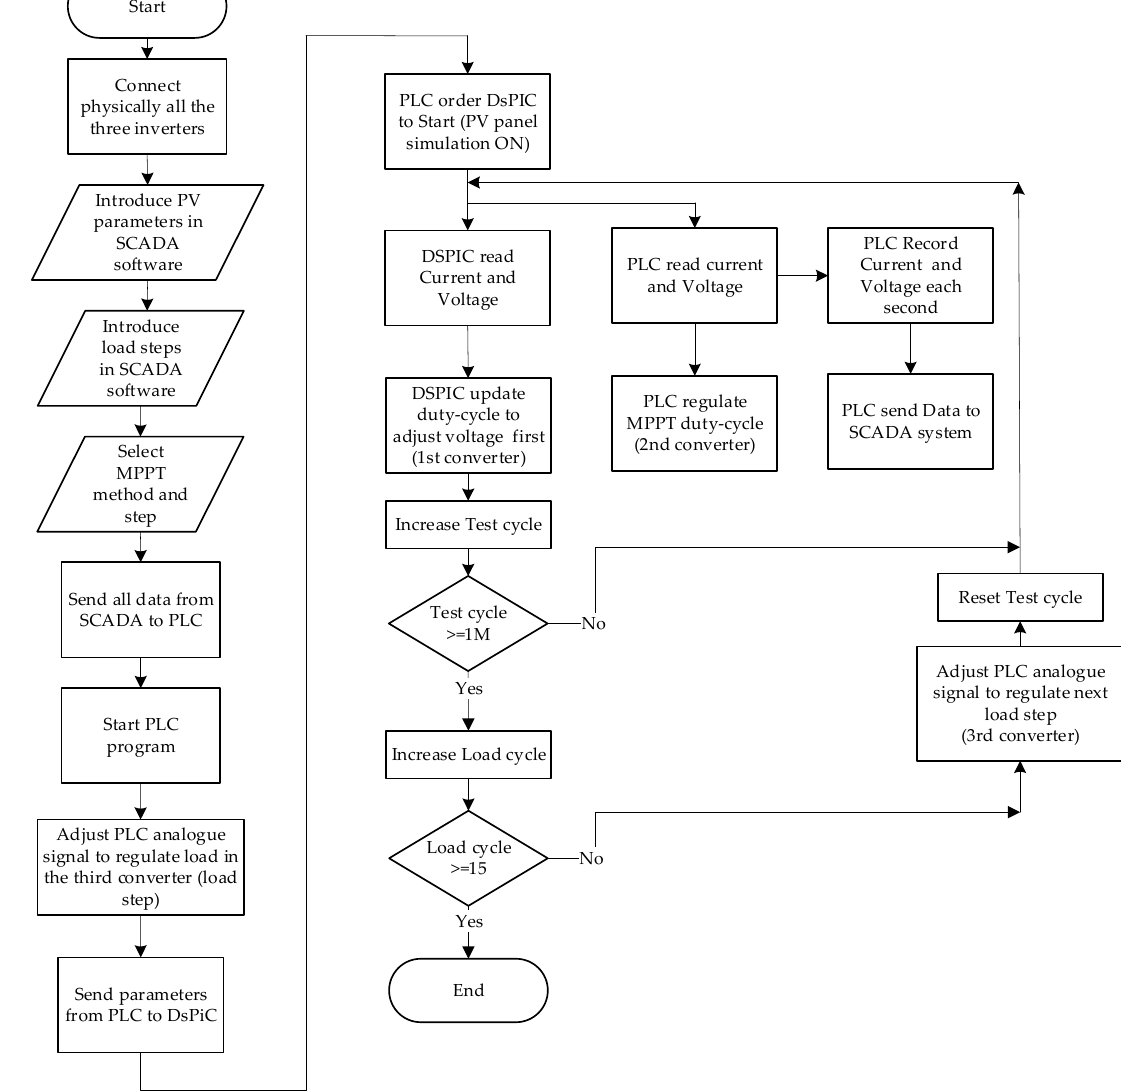
Figure 17. Flowchart of the automated test procedure applied to mode II.